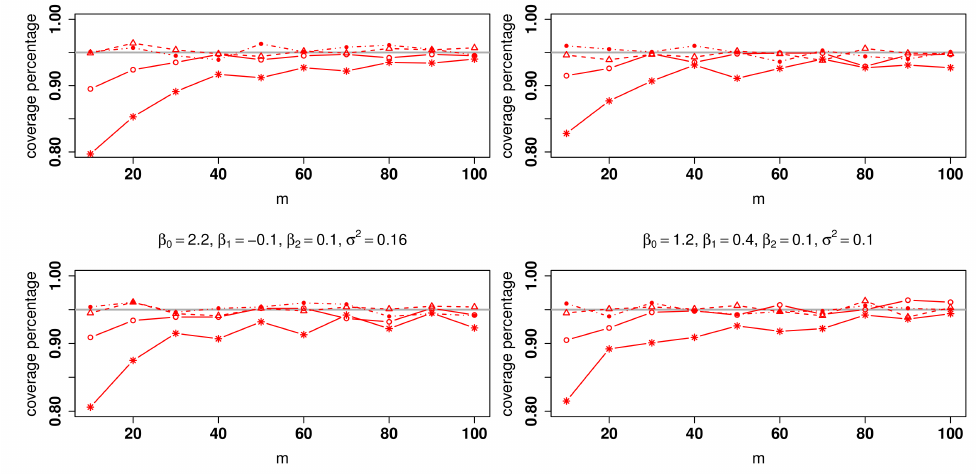
Figure 4. Our 95% coverage percentage for β 0 , β 1 , β 2 , and σ 2 .